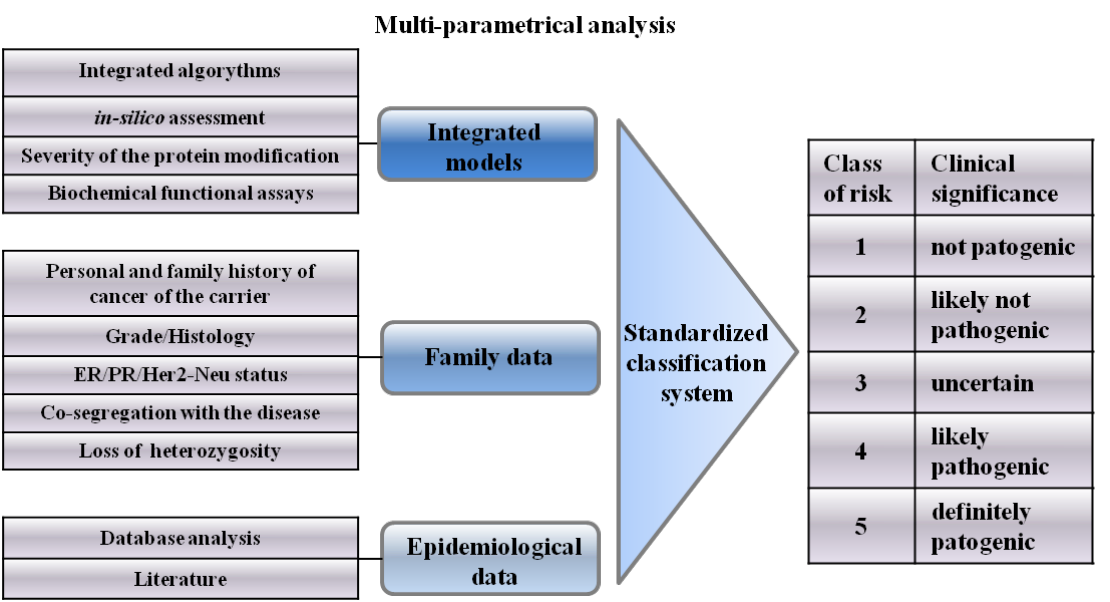
Figure 2. A schematic representation of a multi-parametrical analysis method proposed to help clinicians to individuate the classes of